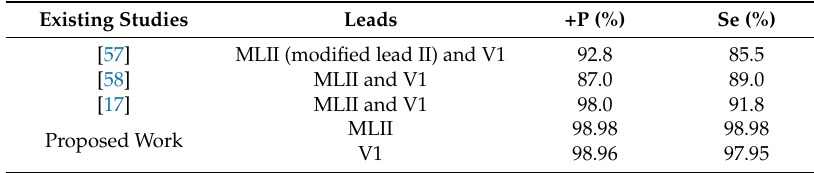
Table 4. Comparison analysis of the proposed work with existing